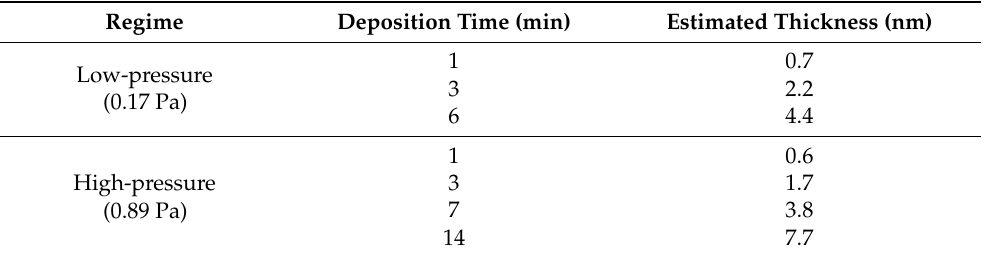
Table 4. Deposition times and estimated thicknesses of the TiO 2 films used as electron selective con- tacts in silicon heterojunction solar cells. The deposition rates used for estimating the thicknesses were 0.73 nm/min and 0.55 nm/min for the low-pressure and for the high-pressure regime,